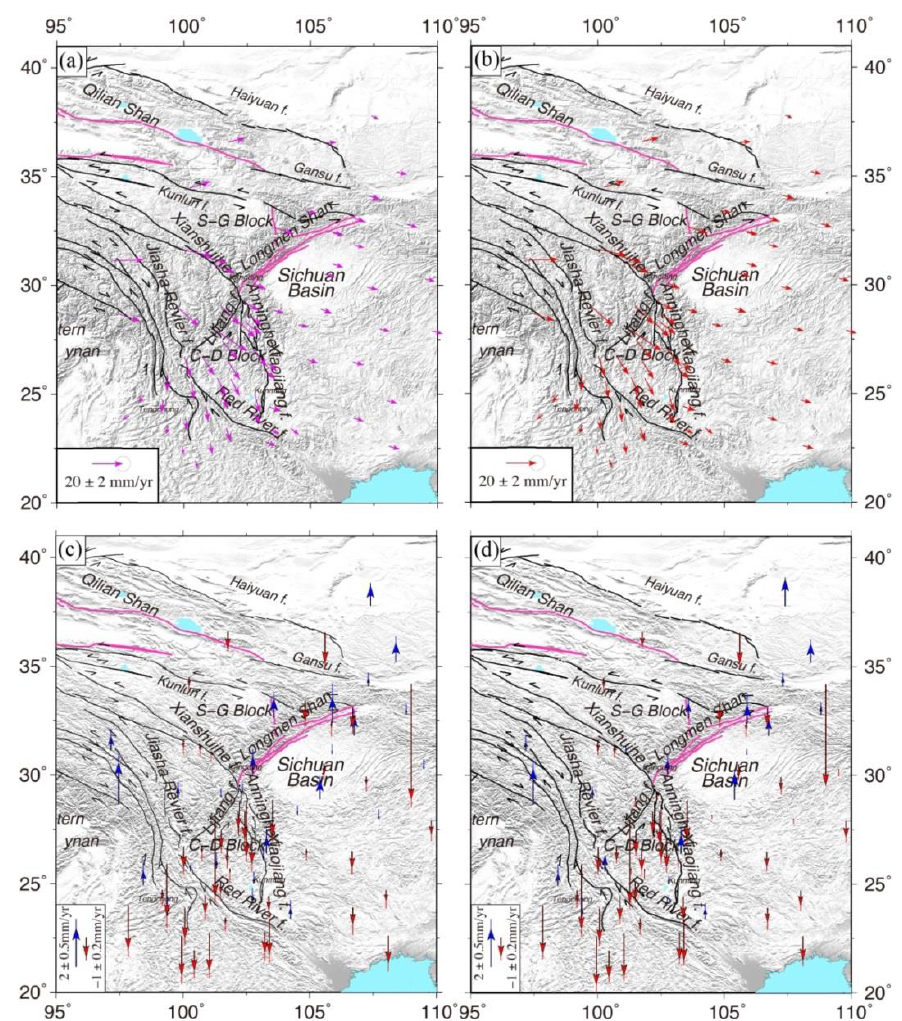
Figure 14. Three-dimensional crustal deformation in the ETP. ( a ) and ( b ) are the horizontal GPS velocities with respect to the stable Eurasian reference frame with an unfiltered CMC and a filtered CMC, respectively. ( c ) and ( d ) are the vertical velocities with respect to the ITRF 2008 frame with an unfiltered CMC and a filtered CMC, respectively.